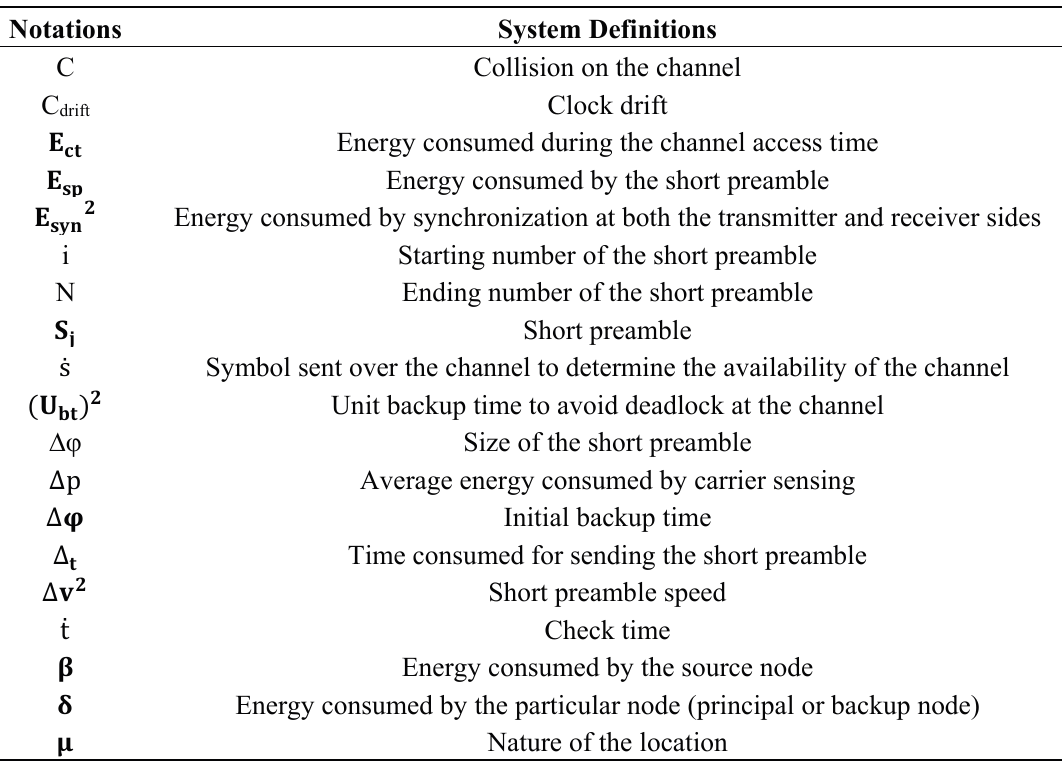
Table 3. Notations and system